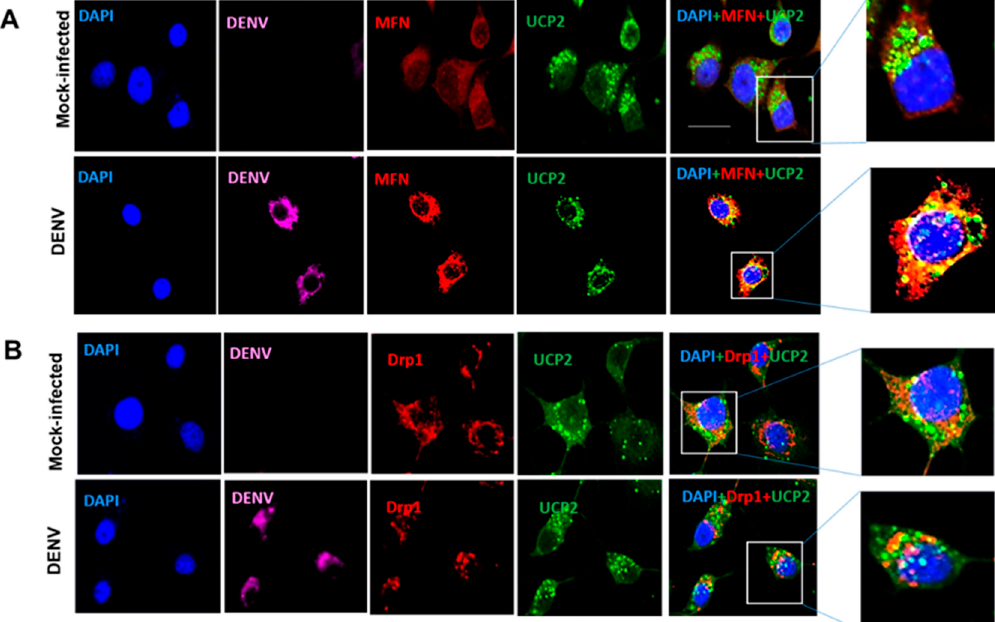
Figure 7. DENV2 induced MFNs translocation into the mitochondria of C6/36 cells. All cells were infected and mock- infected with DENV2 at an MOI of 10 and fixed at 36 hpi. Mitochondria were visualized by anti-UCP2 immunostaining and nuclei were visualized by DAPI stain ( A ) Colocalization of MFN and UCP2 in DENV infected mosquito cells (C6/36). MFN shown in red, UCP2 in green, and DENV in magenta. Magnified images of boxed area show merged fluorescence of MFN and UCP2 (yellow). ( B ) Drp1 does not colocalize with UCP2. Drp1 shown in red, UCP2 in green, and DENV in magenta. The insets show magnifications of the selected zones. The images were taken with an Olympus FluoView 1000 confocal microscope (scale bar, 20 μ m). Representative images of three independent experiments are presented. MFN: mitofusins. Drp1: dynamin-related protein 1. UCP2: uncoupling protein 2. DENV: dengue virus.